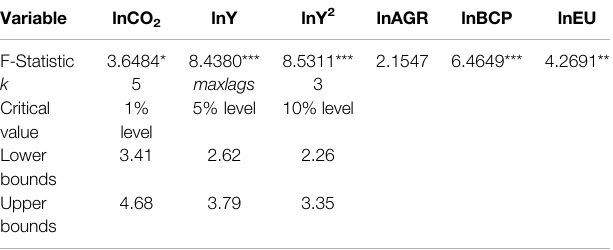
TABLE 4 | Estimates of ARDL bounds test for